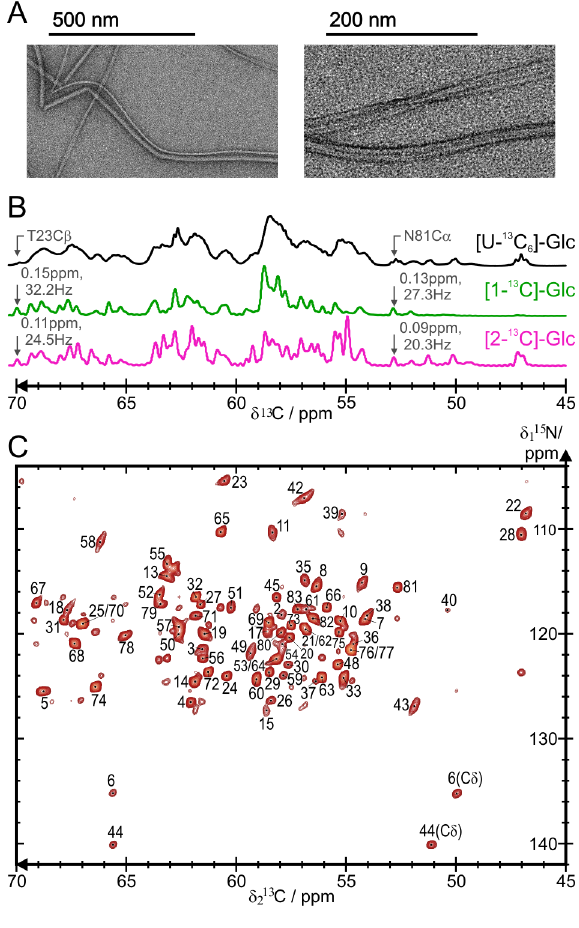
Figure 3. Solid-state NMR spectroscopy of Shigellaflexneri MxiH needles. A , Transmission electron microscopy images of WT Shigella flexneri needles used for solid-state NMR measurements. B , 1D 13 C cross- polarization spectra of [uniform- 13 C 6 ]glucose (Glc)-labeled (black), [1- 13 C]Glc-labeled (green) and [2- 13 C]Glc-labeled (magenta) needles. Representative line-widths are indicated for two resonances (T23C b and N81C a ) for the sparsely-labeled samples. The free-induction decay of the signal was recorded for a total of 8192 scans, with signal remaining after an acquisition time of 60 ms. No apodization function was employed in the processing. C , N-C a spectrum of [2- 13 C]Glc-labeled needles. The 2D spectrum correlates backbone amide nitrogen frequencies ( d 115 N) to backbone C a frequencies ( d 213 C). N-C a cross- peaks are numbered according to the MxiH amino acid sequence and N-C d cross-peaks of prolines are indicated. Unmarked cross-peaks correspond to sequential correlations. Spectra were recorded at a magnetic field of 21.1 T (850 MHz 1 H resonance frequency) at 5.5 u